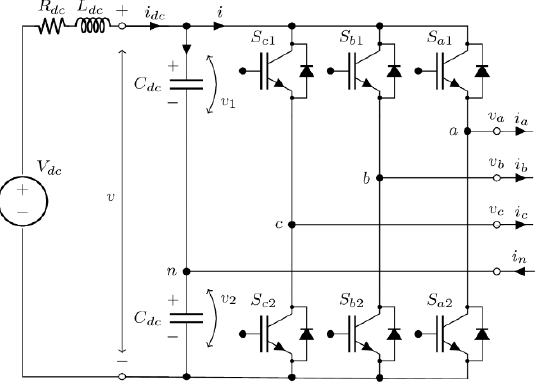
Figure 1. Circuit scheme of a three-phase, four-wire, split capacitor VSI.